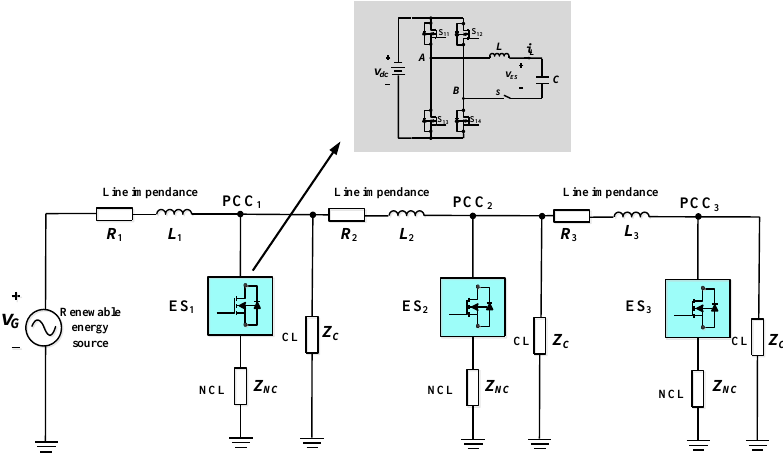
Figure 1. Microgrid with three ES-2 (electric springs (ES) exchanging both active and reactive power with the smart load (SL) branch to stabilize the critical load (CL) voltage and frequency).